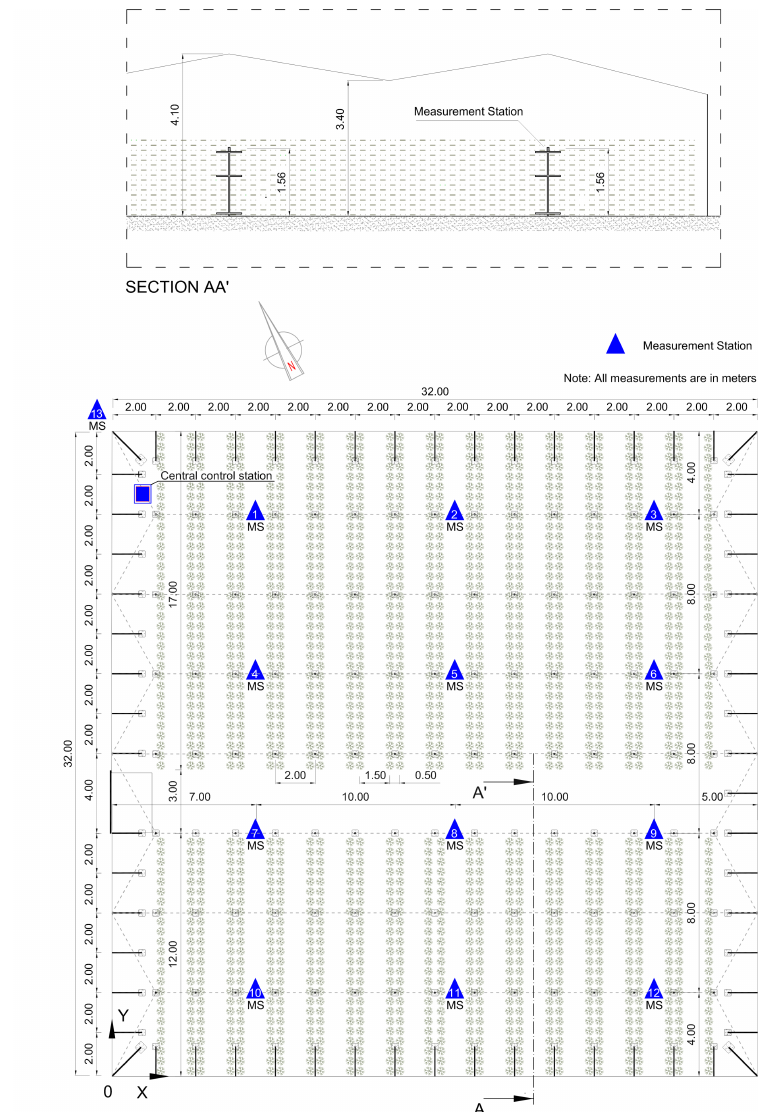
Figure 3. Drawing of the greenhouse, where are indicated the locations of the measurement